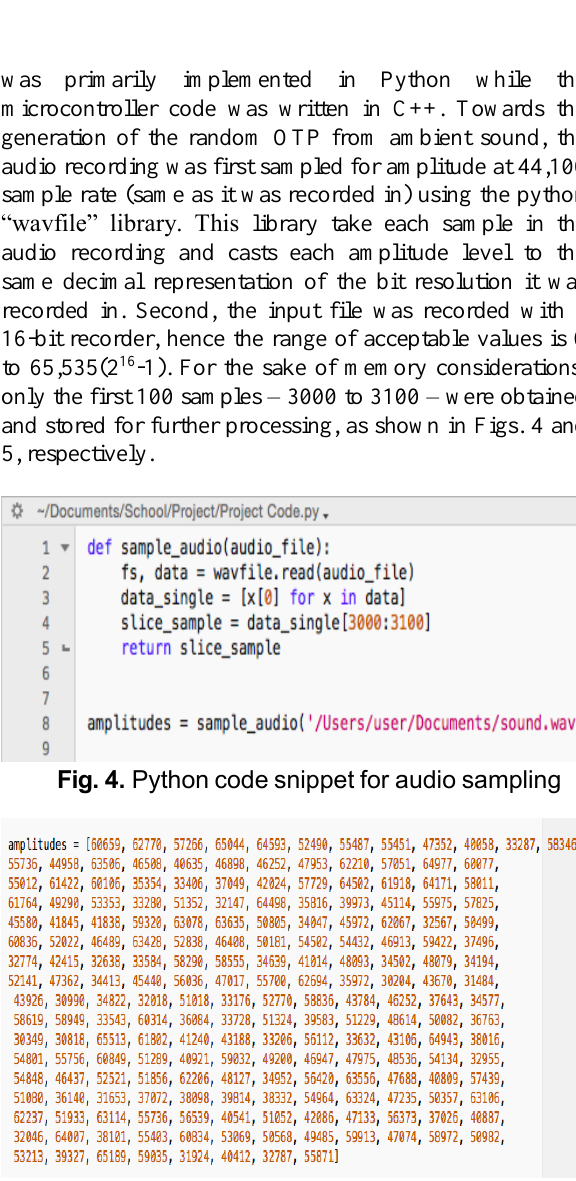
Fig. 5. Array of 100 audio samples, output